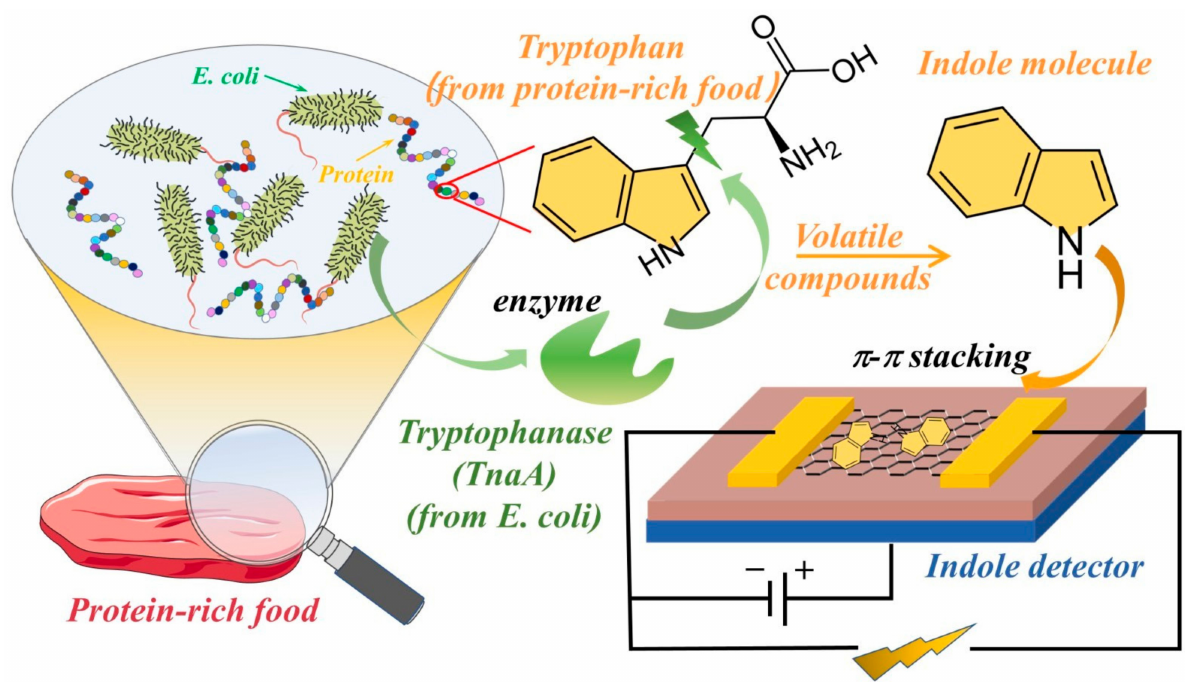
Figure 1. The schematic of metabolic volatile indole detector using